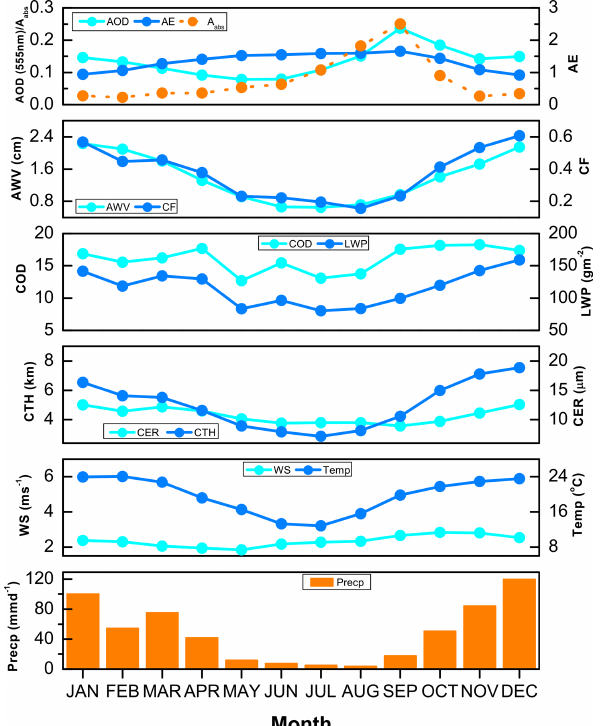
Figure 12. Intercomparison of average monthly variation of aerosol (AOD, AE, A abs ), AWV, cloud (CF, LWP, COD, CTH, CER), and meteorology (WS, TEMP, PRECP) parameters over central South